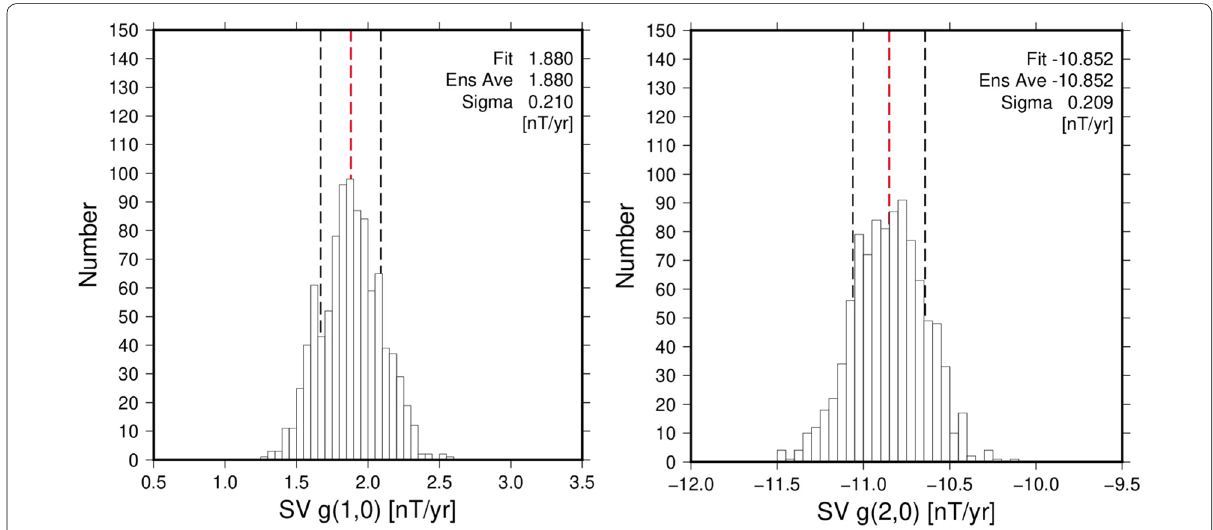
g 0 1 and g 0 2 ). The black and red dashed lines denote the range of one sigma ˙ ˙